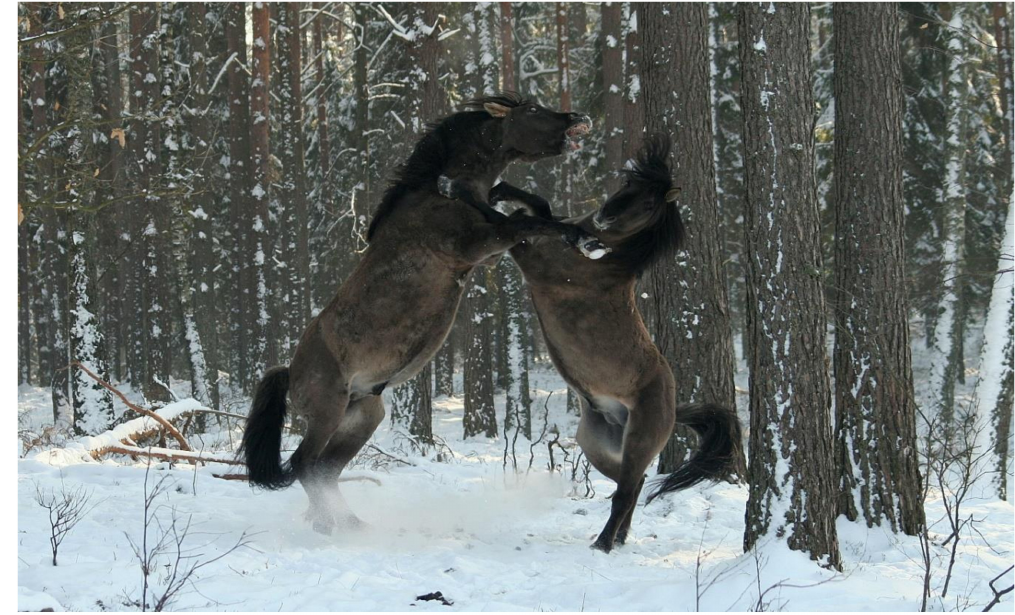
Figure 1. Fighting Konik stallions (photo by Michał